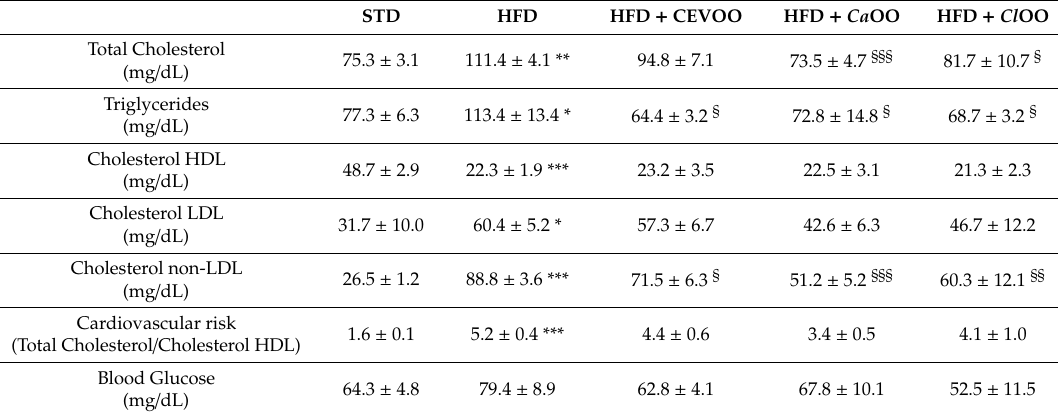
Table 8. Data of lipid and glycemic profiles observed after three weeks of treatment.